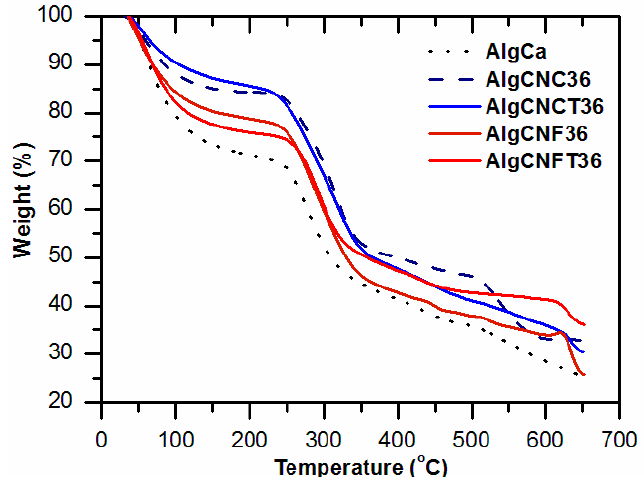
Figure 4. Thermogravimetric analyses of pure alginate and nanocellulose-alginate gels. Influence of the different nanocellulose types (CNC, CNCT, CNF, CNFT, at 36 wt %) on the thermal stability of the alginate gels.